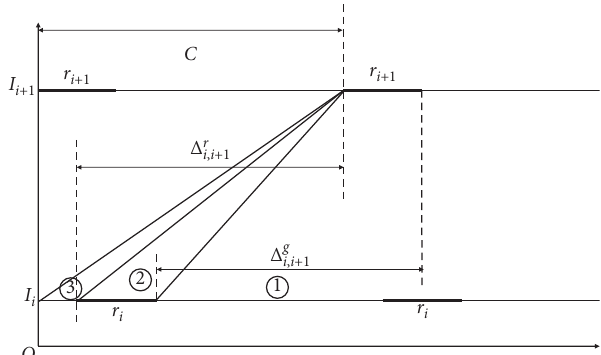
Figure 5: Classification of backward overlapping spatiotemporal figures according to